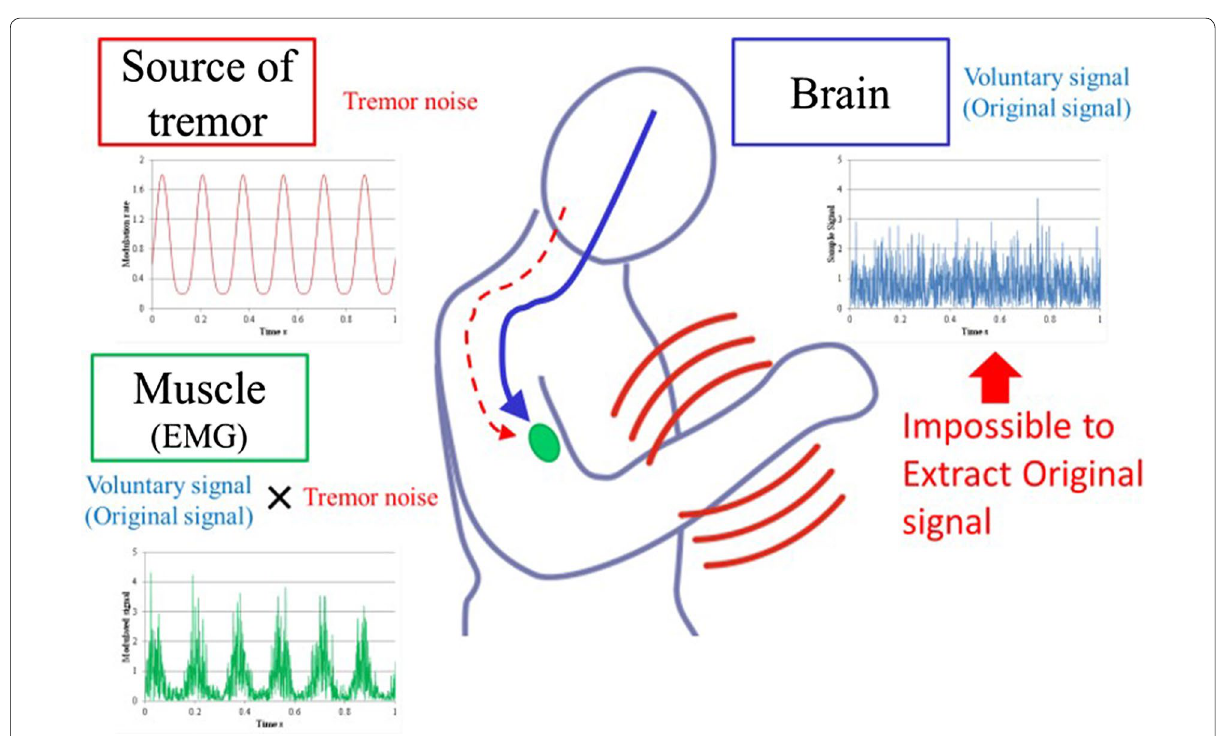
Fig. 9 Problem of how to evaluate the proposed demodulation